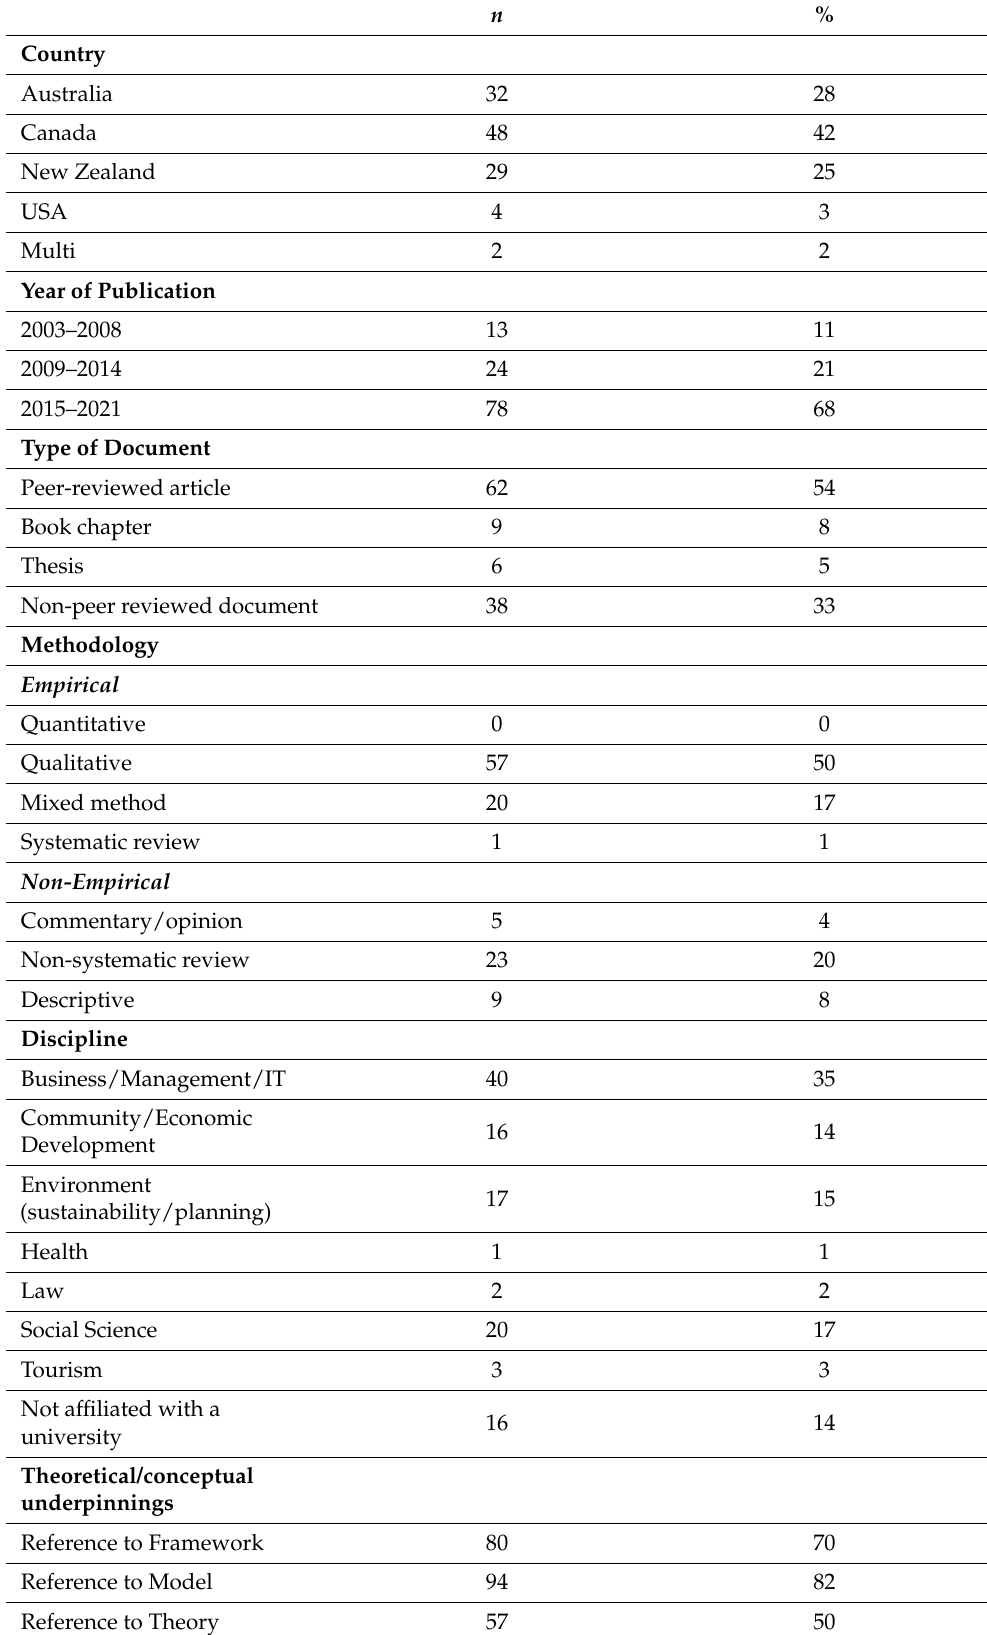
Table 2. Descriptive characteristics of included documents ( n =